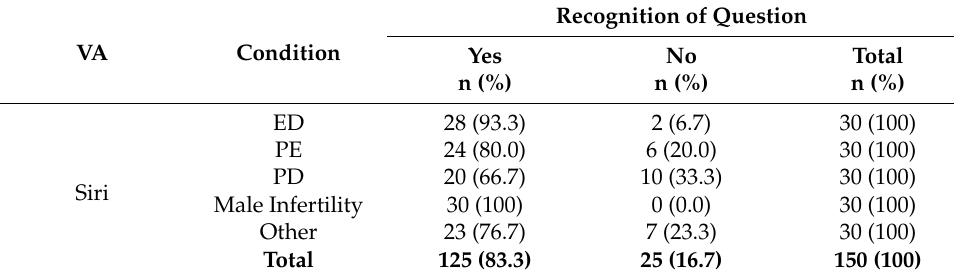
Table 1. Recognition of questions by